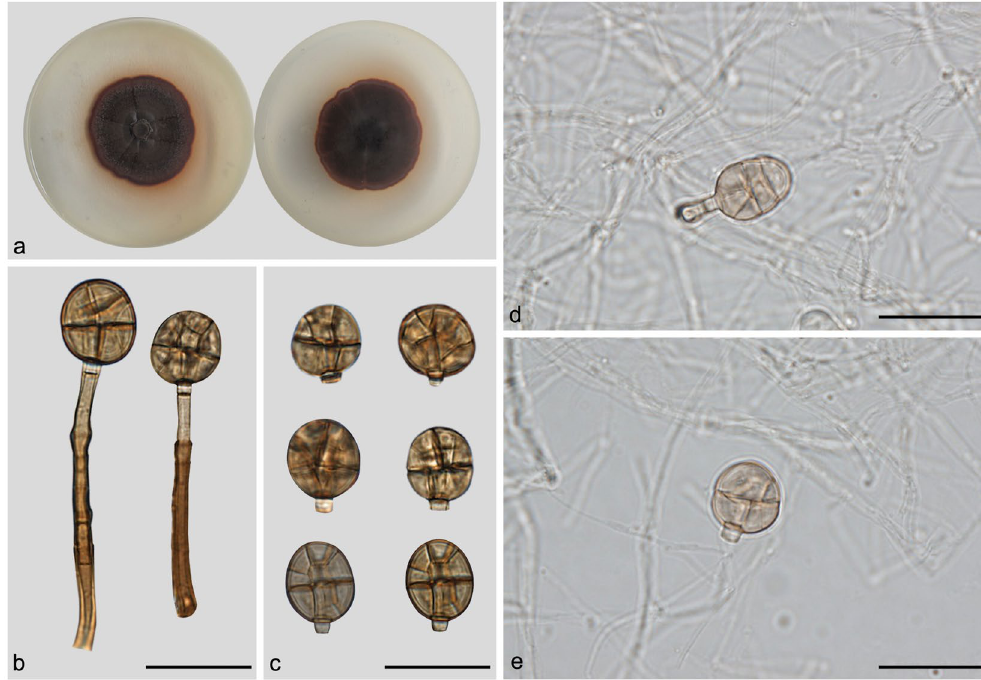
Figure 10. Junewangia lamma. ( a ) Colony on PDA (surface and reverse). ( b , c ) From natural substrate (HSAUP H4695): ( b ) Conidiophores with conidia, ( c ) Conidia. ( d , e ) From PDA (CGMCC 3.18652): Conidiophores and conidia. — Scale bars = 20 μ